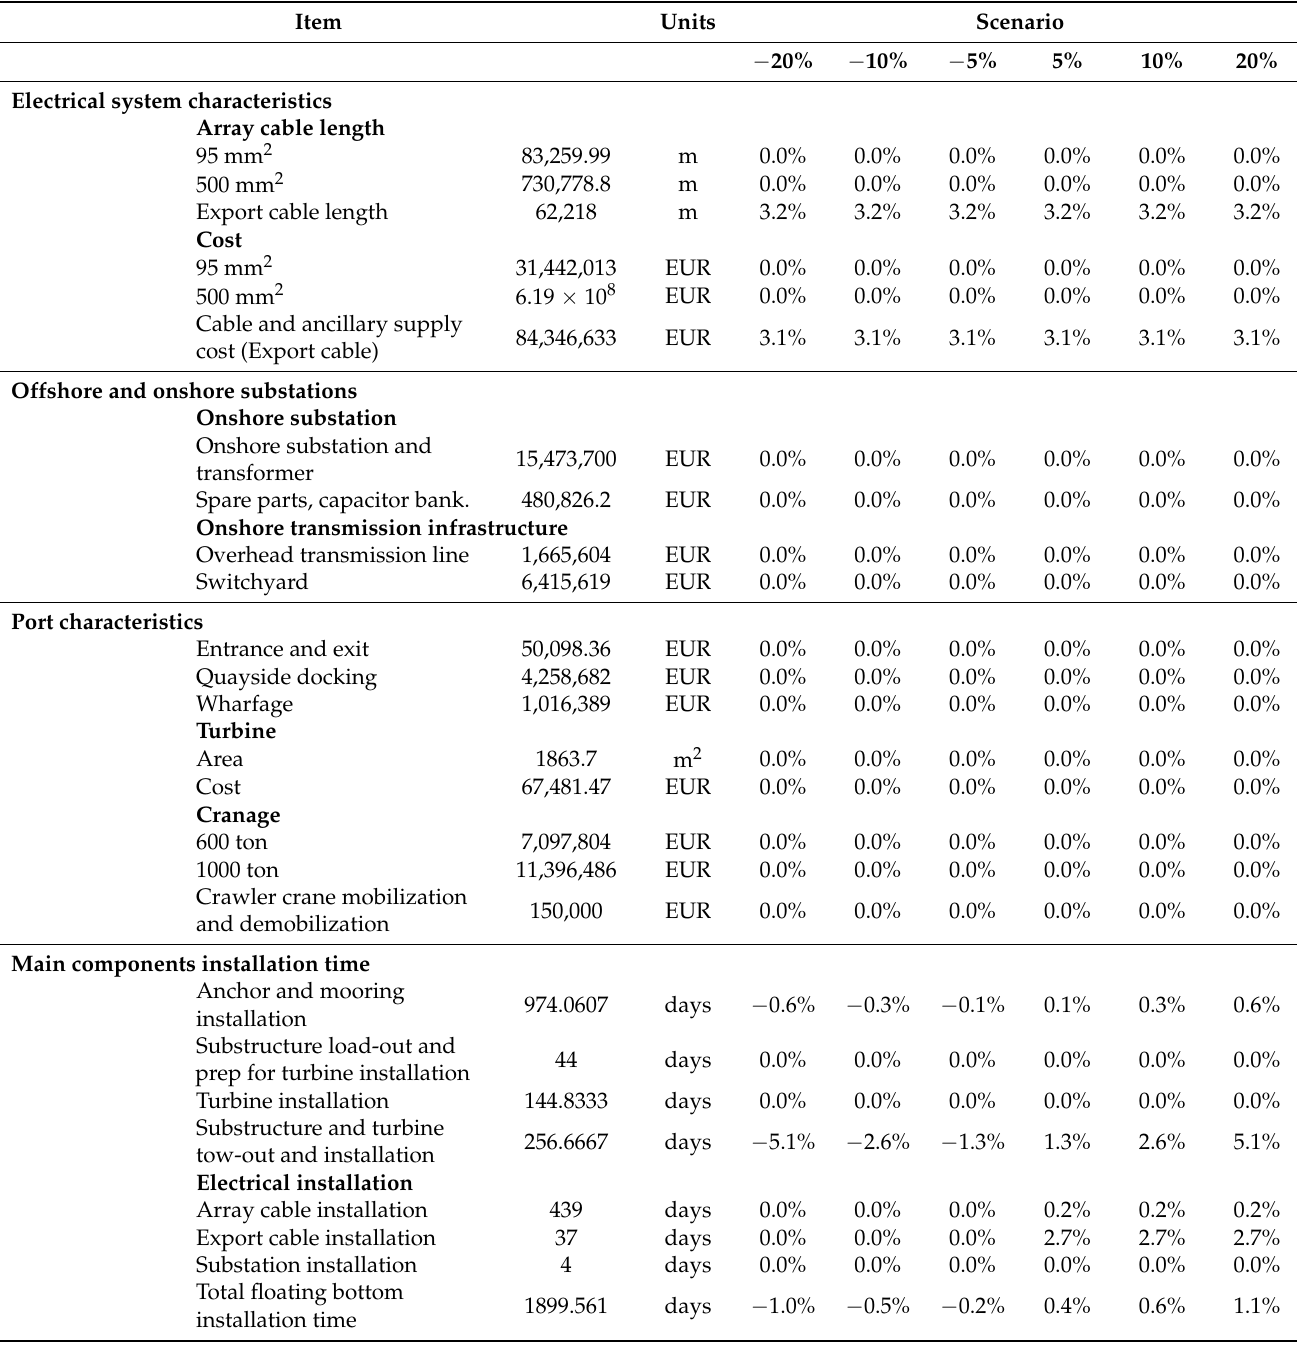
Table A4. Variability associated with the distance to the